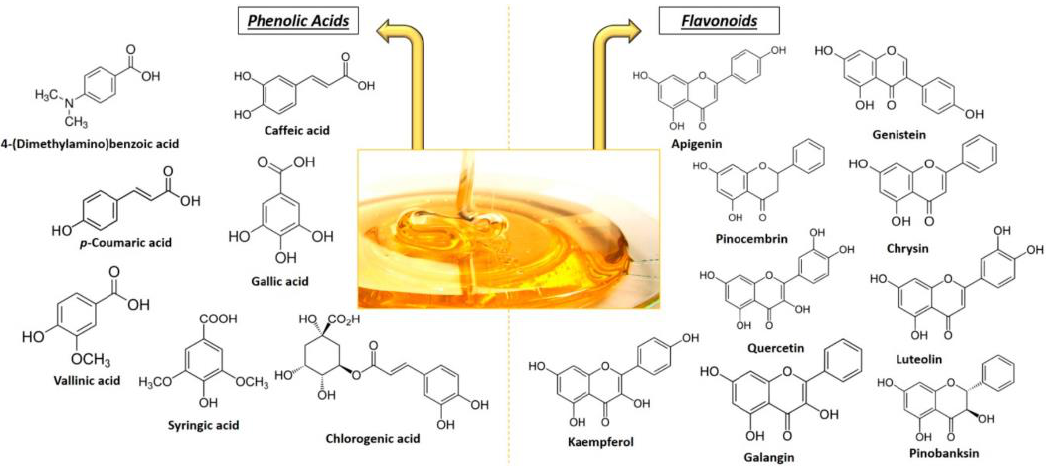
Figure 2. Most common compounds identified in honey. Reprinted from [34].